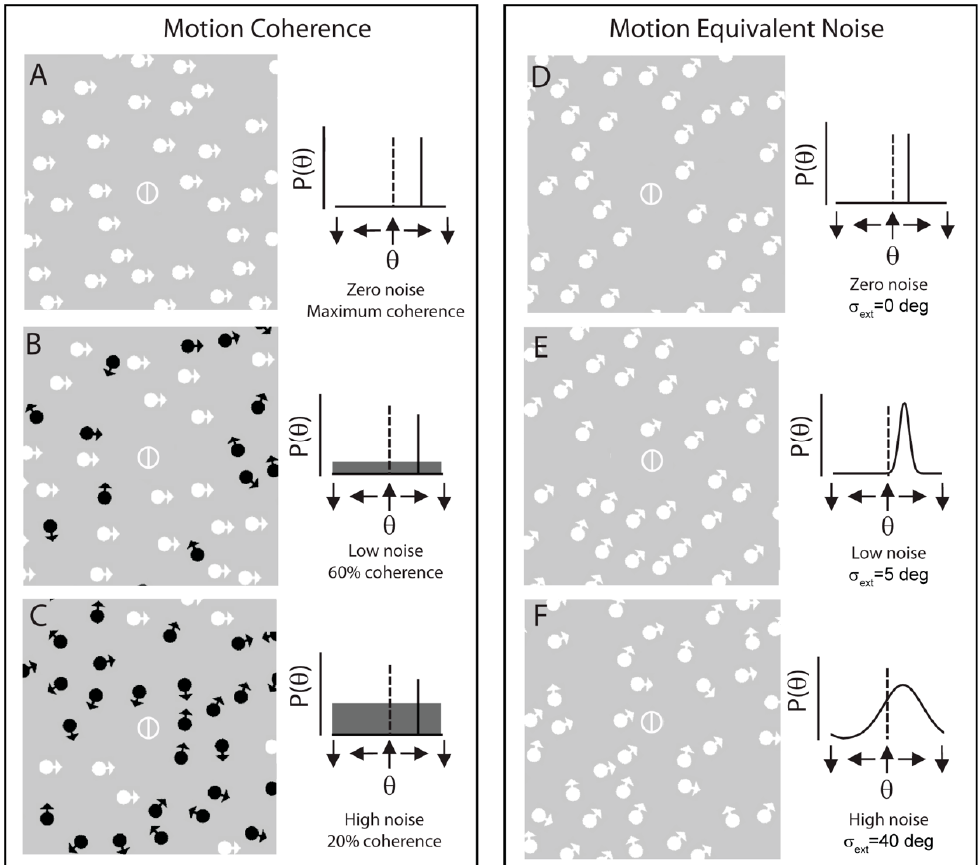
Figure 1. An example of the displays used for motion discrimination tasks, using motion coherence ( A–C ) and equivalent noise ( D–F ) paradigms. In both tasks, the participant must classify the signal direction (or average signal direction) as right or left of vertical. In the motion coherence paradigm, external noise was added to the stimulus by assigning a subset of dot random directions. In the equivalent noise paradigm, external noise was added to the stimulus by increasing the standard deviation of motion directions displayed by the noise dots. In A–C, directions of signal motion are indicated by white arrows; directions of noise motion are indicated by black arrows. (In the actual experiment all signal and noise elements were comprised of white dots. Noise dots are shown in black for illustration purposes only.) Associated signal and noise probability distribution functions are presented alongside each example display; in these, the reference direction is denoted by a dotted black line and the signal probability density function is denoted by a solid black line. Adapted from Tibber et al. [32].